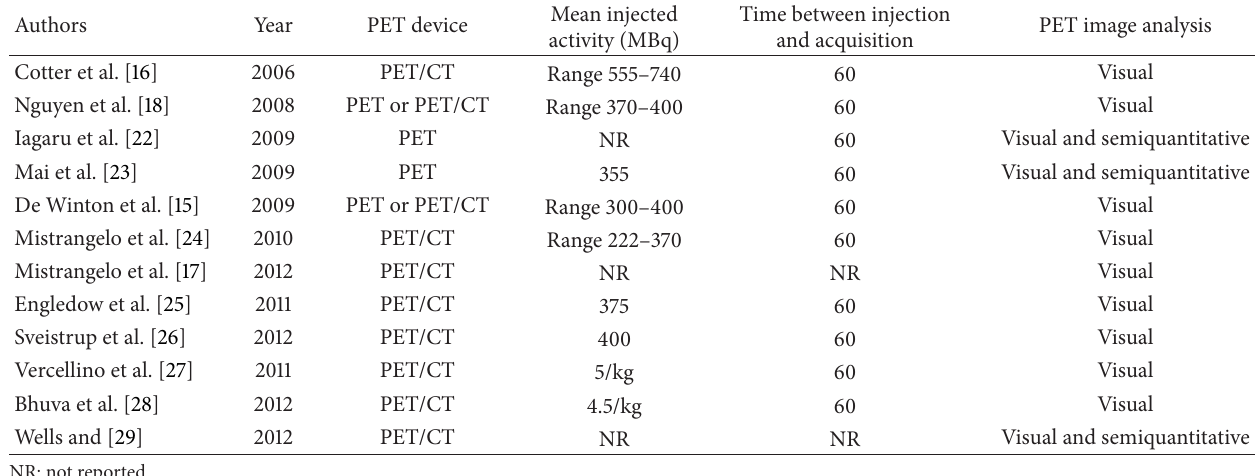
Table 2: Methodological aspects of 12 selected studies.